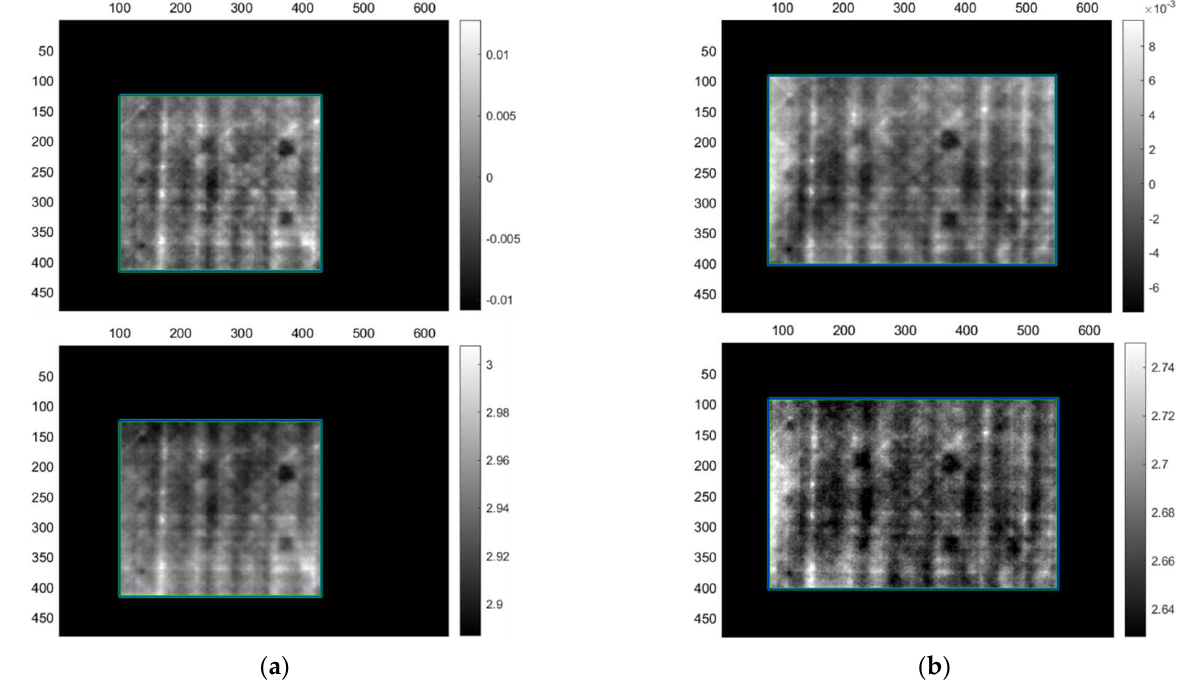
Figure 10. Step-heating thermography PCT (top) and FT phase (bottom) mirror images from CF-PET-CF sandwich sample. ( a ) Images from acquisition SHS3 without paint and ( b ) SHS5 with paint. Table 13. Step-heating results from the inspection of the CF-PET-CF sandwich sample.